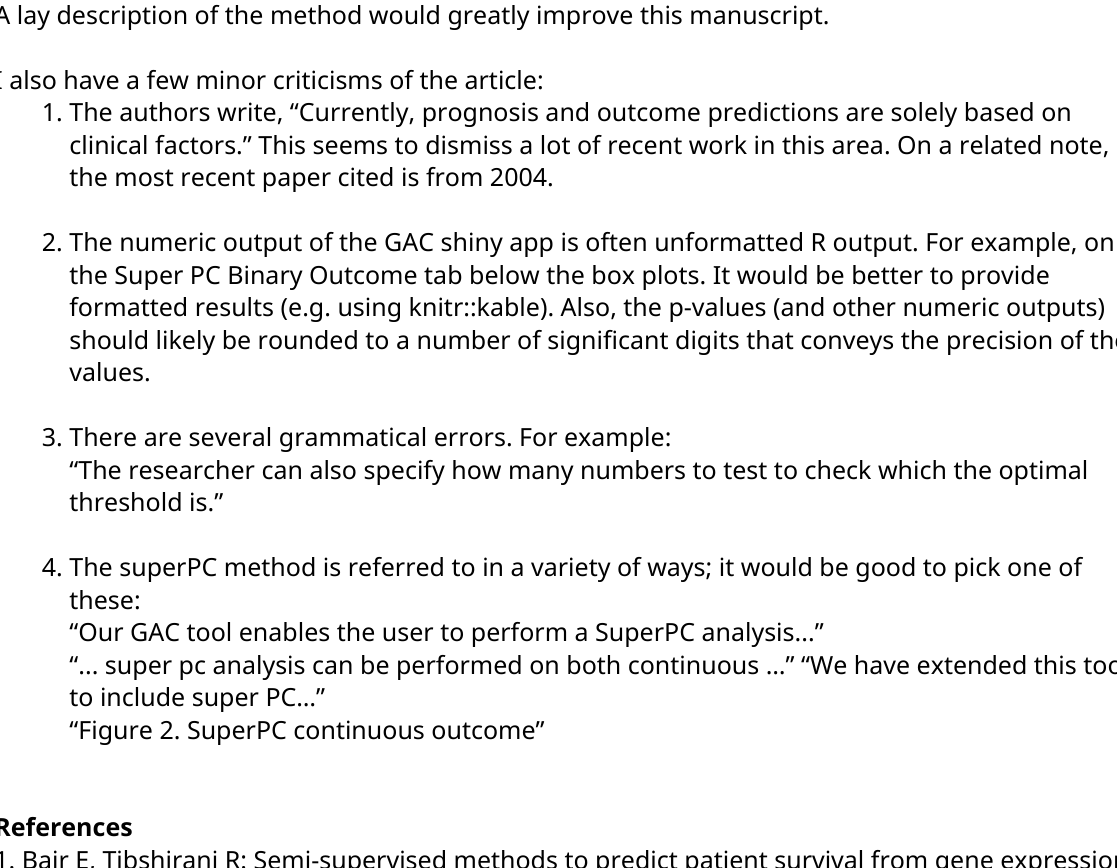
“Figure 2. SuperPC